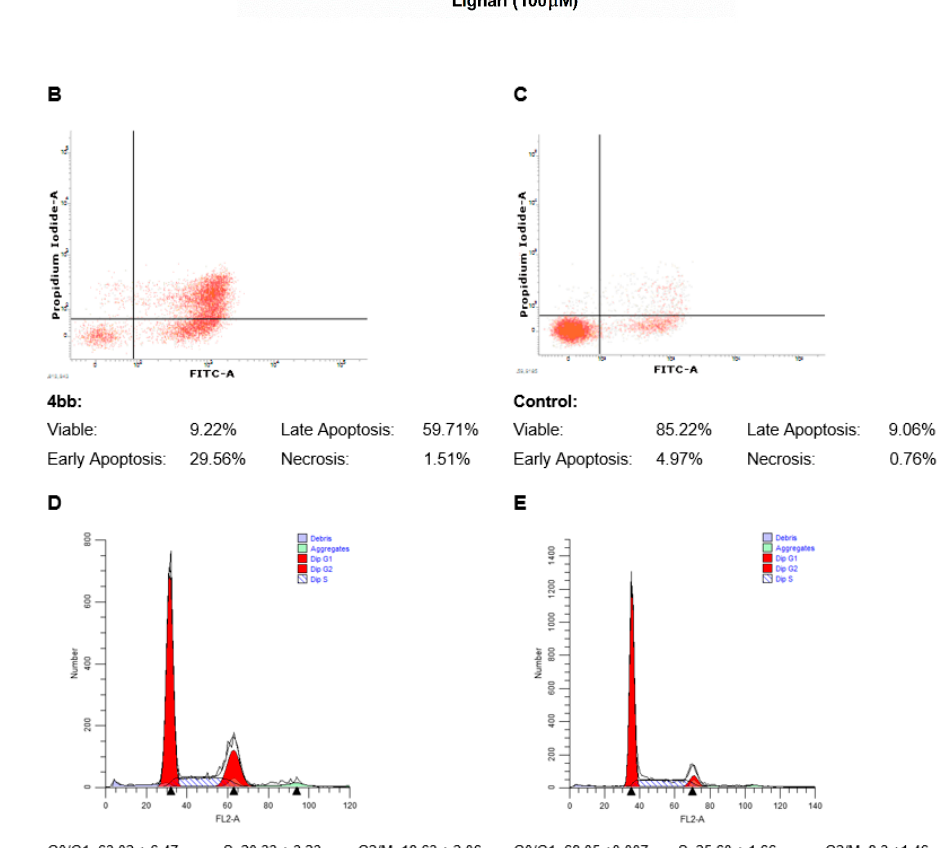
Figure 4. ( A ) Cell survival (by a measure of metabolic activity) of Jurkat T-cell leukaemia cells incubated with 100 µ M of lignans and lignan analogues for 48 h. The data represents means of triplicate experiments and is shown as means ± SEM ( n = 3). The positive control (not shown) had a growth of 100%. Significance of the compound activity compared to the control is expressed: (*) p -value <0.05; (**) p -value <0.01; (***) p -value <0.001. ( B ) Dotplot showing the viability of Jurkat T-leukaemia cells after incubation with 100 µ M 4bb for 24 h followed by labelling with annexin V/propidium iodide and analysis using flow cytometry. Cells in the bottom-left quadrant represent viable cells, bottom-right quadrant are positive for annexin V and are in early apoptosis, top-right quadrant are double positive for annexin V and propidium iodide and are in late apoptosis, and top-left quadrant are only positive for propidium iodide and are undergoing necrosis. ( C ) Negative control showing the viability of vehicle-(DMSO) treated Jurkat T-leukaemia cells. ( D ) Cell cycle analysis of unsynchronized cells incubated in the presence of 100 µ M 4bb or E: vehicle for 24 h. DNA content of the cells was determined by flow cytometry. Percentage of cells in each stage of the cell cycle (average of three replicates ± SD is